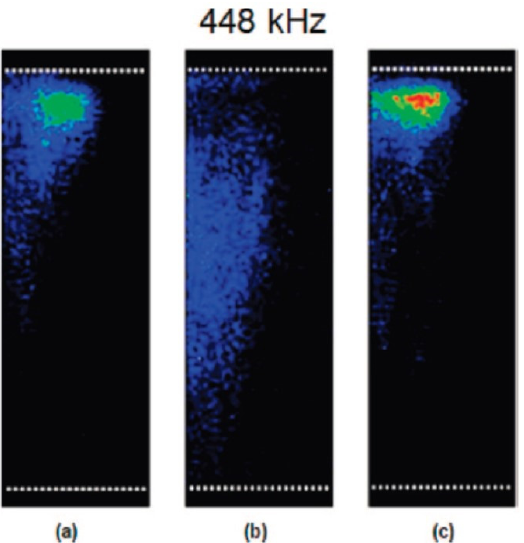
Figure 26. Images showing the effect of SDS on the MBSL structure generated at a frequency of 448 kHz and at a power of 1.1 W/cm 2 : ( a ) water, ( b ) 1 mM SDS, and ( c ) 10 mM SDS [59]. Exposure time was set to collect 2 × 10 5 acoustic cycles. The white dotted lines above and below the MBSL structure denotes the liquid surface and the transducer position, respectively. The center axis of the vessel is located on the left side of the images. Copyright 2008, with the permission from American Chemical Society.